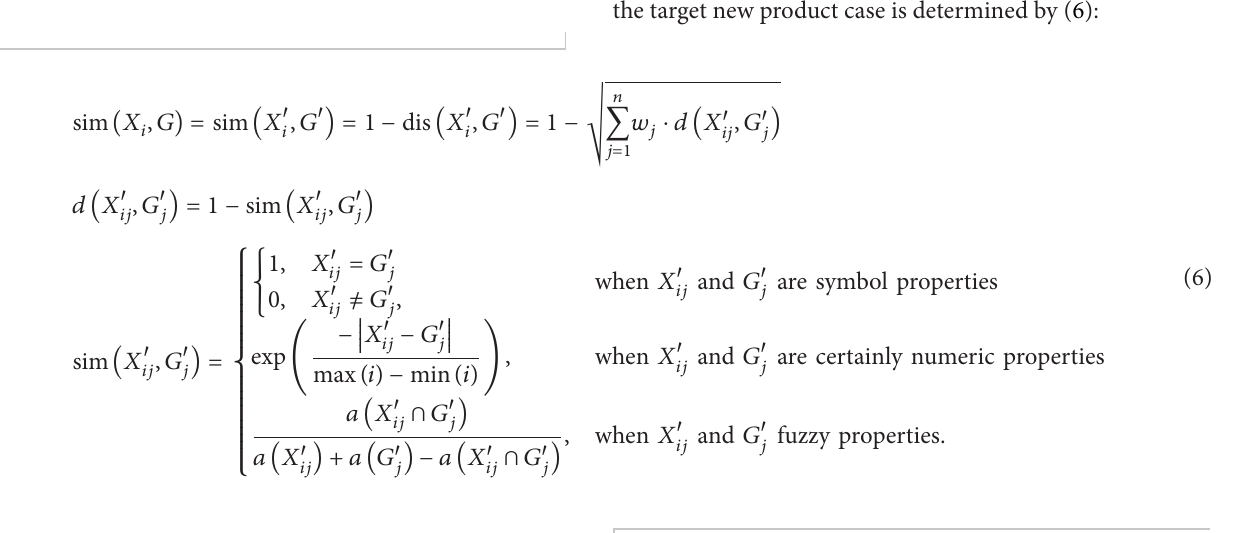
Table 1: The influencing gap 𝛿 (𝑝) 𝑖𝑗 on different levels of customers. 𝛿 (𝑝) 𝑖𝑗 Definition Influence of factor ( 𝑐 ) on customer ( 𝑖 ) is the same as 0 2